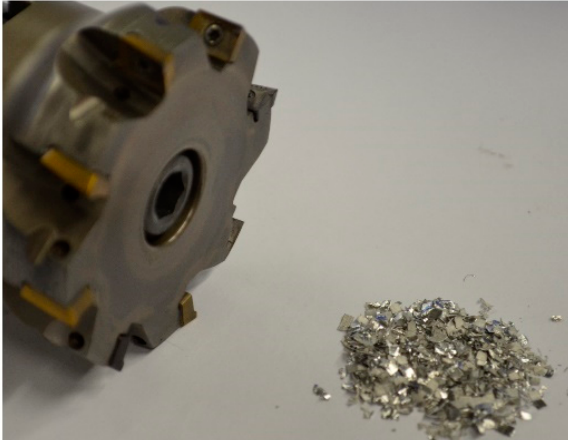
Figure 2. In the studies used chips and the associated tool.